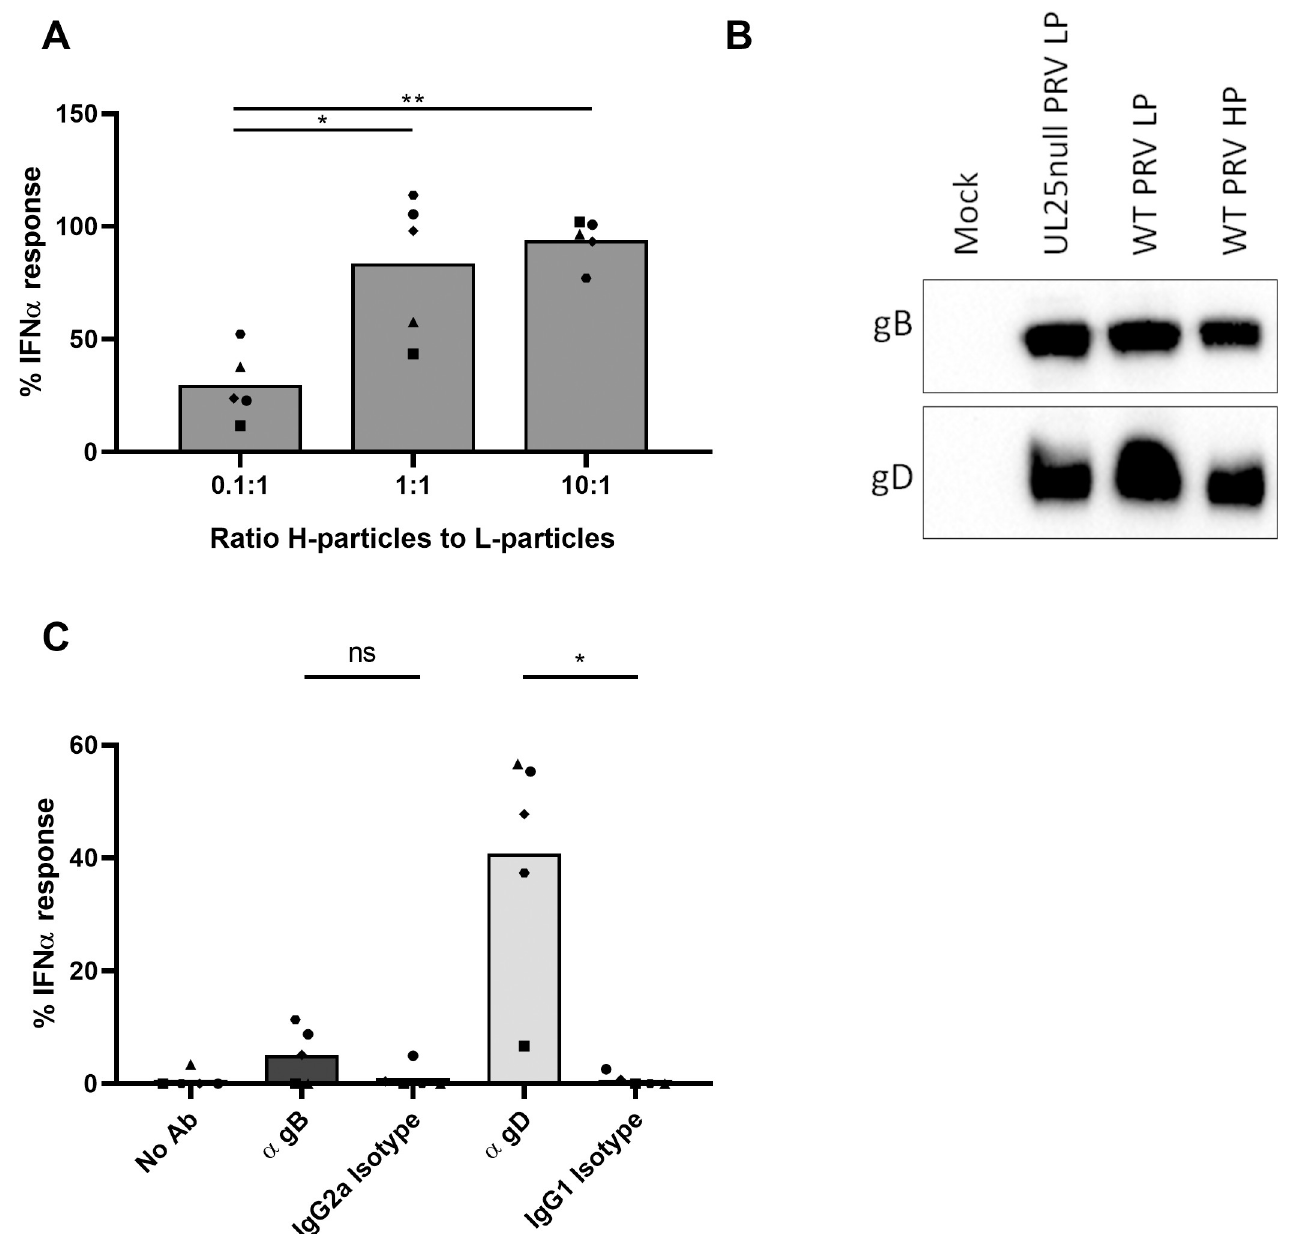
Fig 7. The inhibitory effect of PRV L-particles on H-particle-induced IFN α production by pDC depends on the viral gD envelope glycoprotein. (A) Porcine PBMC were incubated for 22h with a fixed number of L-particles or a corresponding mock sample and increasing numbers of H-particles. The number of H-particles in the lowest H-to-L-particle ratio of 0.1:1 corresponds to the same amount of H-particles as used in the previous experiments i.e. 10 6.8 PFU/ml, with the two 10 fold increments of H-particles referred to as 1:1 and 10:1. IFN α responses are normalized to the mock condition (set to 100) for each of the five independent repeats. (‘ns’ not significant, ‘ � ’ P < 0.05, ‘ �� ’ P < 0.01). (B) Western blot analysis of density gradient purified PRV L-particles from UL25null PRV Kaplan-infected ST cells and WT PRV Kaplan-infected ST cells and H-particles from WT PRV Kaplan-infected ST cells. Antibodies against the viral glycoproteins gB and gD were used. (C) Purified UL25null L-particles or corresponding mock samples were incubated with or without 10 μ g/mL of different monoclonal antibodies at 37˚C for 1h, followed by two centrifugation steps and finally L-particles were resuspended in pDC medium and added to porcine PBMC together with H-particles (corresponding to a 100:1 ratio of L-to-H-particles). Supernatant was collected 22h later and IFN α responses are shown relative to the mock samples (set to 100) for each of the five independent repeats. (‘ns’ not significant, ‘ � ’ P < 0.05).